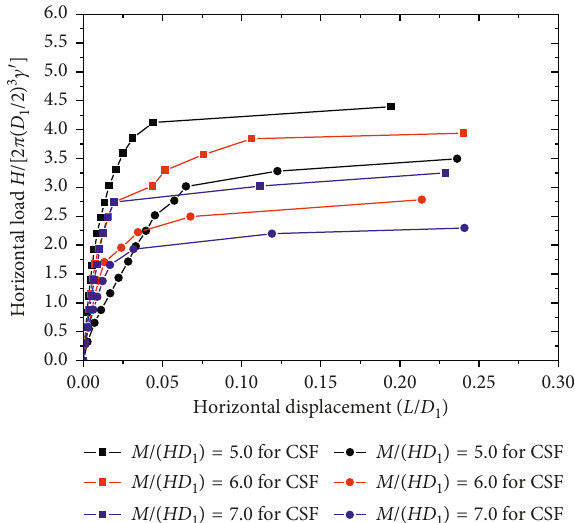
Figure 8: Comparison of horizontal displacement-horizontal load curves for cone-shaped foundation with circular foundation under different M /( HD 1 )